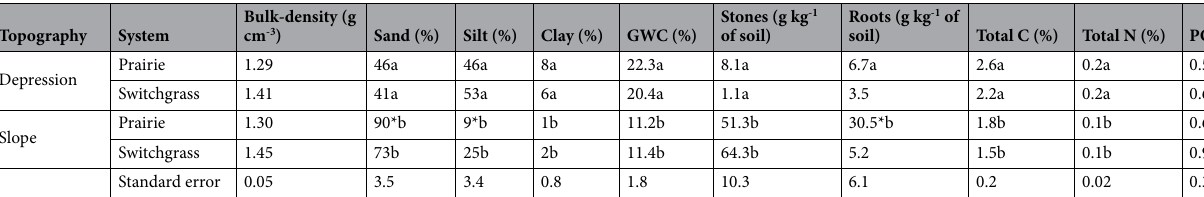
Table 1. Summary of basic soil characteristics for the studied prairie and monoculture switchgrass systems at the two topographical positions. Shown are means (n = 6) and standard errors for each system and topographical position. GWC is gravimetric water content at the time of sampling; POM is particulate organic matter. Stars (*) indicate significant differences between cropping system within each topography (p < 0.05); letters indicate significant differences between the topographical positions within each cropping system (p < 0.05). No stars or letters are shown when the differences are not statistically significant.